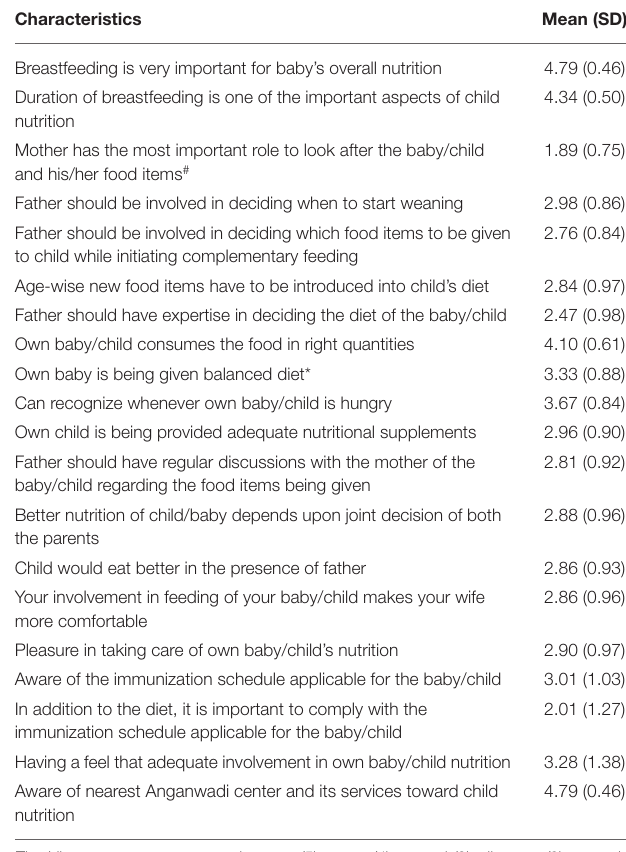
TABLE 1 | Demographic characteristics of the study population ( N = 450). Characteristics